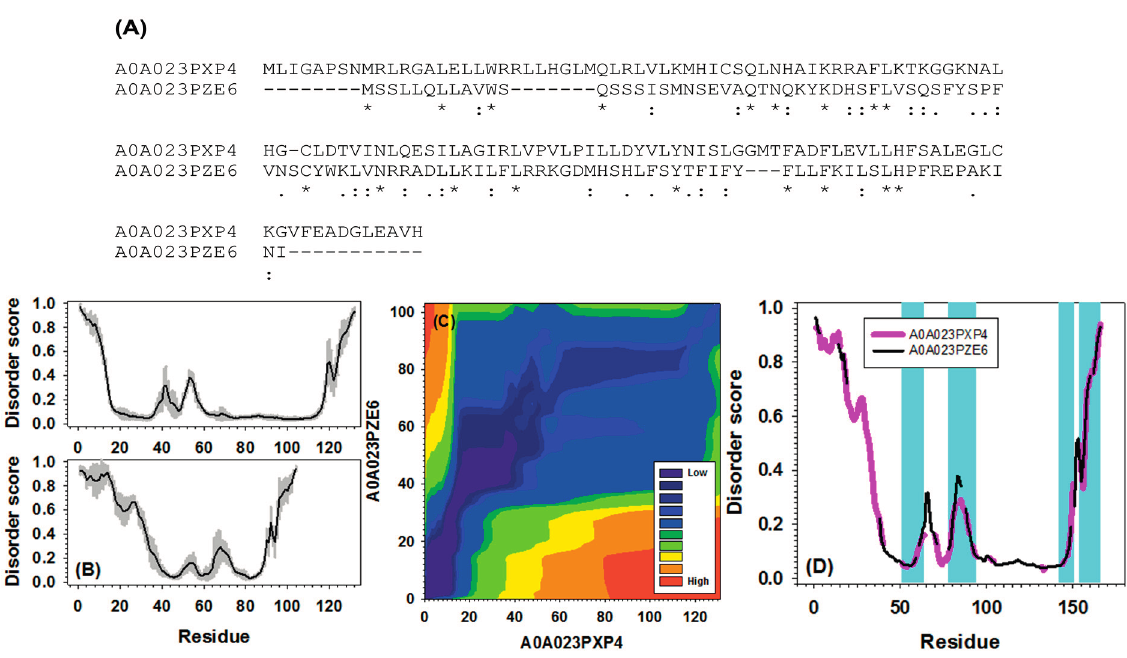
Figure 4. Identified alignment path for a sequence pair (Uniprot IDs: A0A023PXP4 and A0A023PZE6) from the Yeast dataset. ( A ) Traditional pair-wise sequence alignment. “ * ”, “:”, “.”, and “-” stand for identical amino acids, highly similar amino acids, similar amino acids, and gaps, respectively; ( B ) Original disorder predictions for A0A023PXP4 ( upper panel) and A0A023PZE6 ( lower panel). The gray shadow behind the disorder curves is estimated prediction error from PONDR-FIT; ( C ) Alignment path between two sequences A0A023PXP4 (pink) and A0A023PZE6 (black) along the alignment path. Many pairs